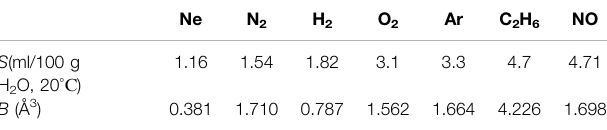
TABLE 1 | Solubility and polarizability of